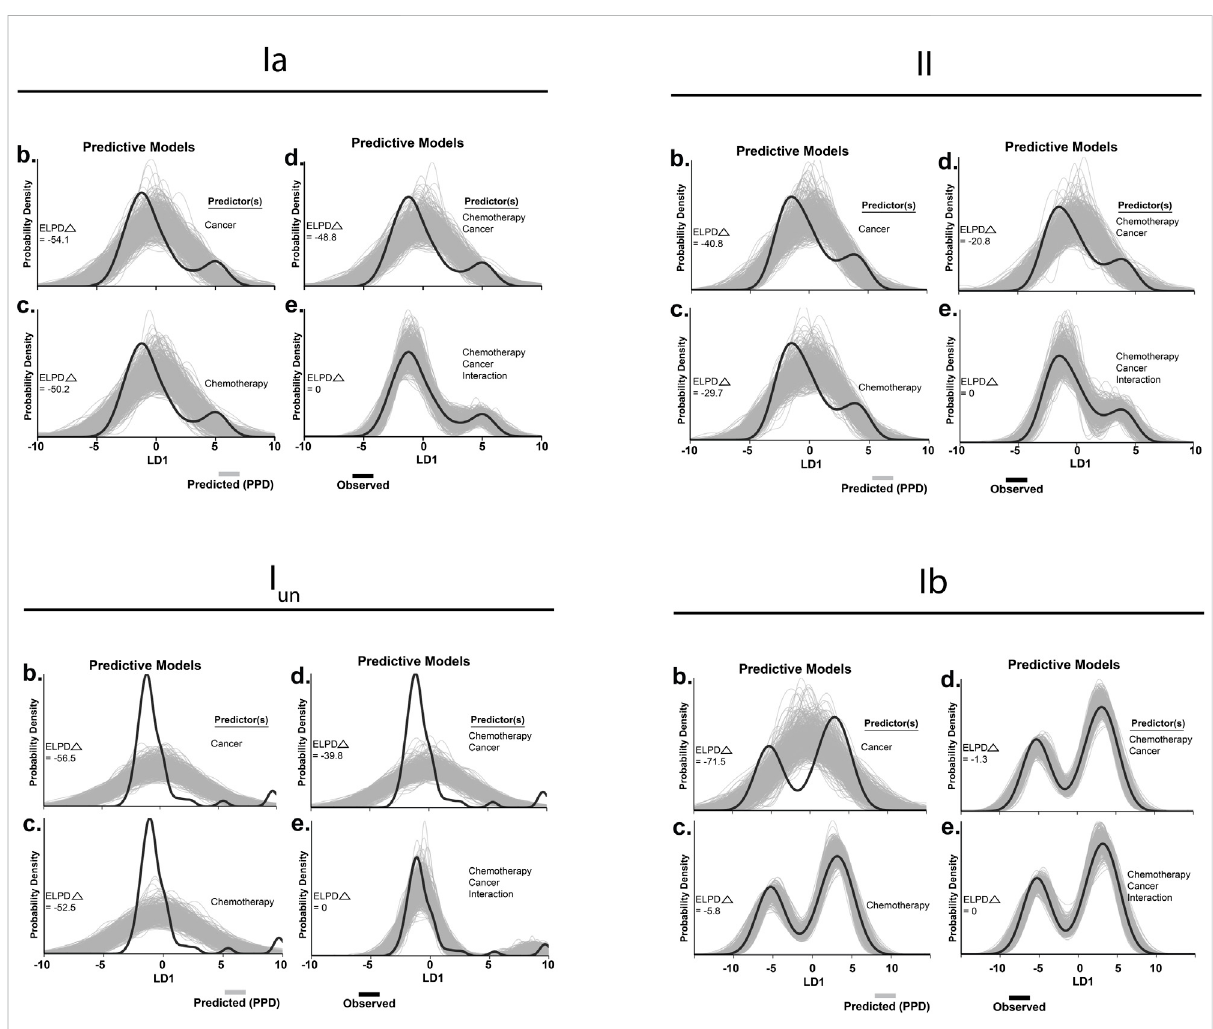
FIGURE 4 Hierarchical Bayesian modeling. Tests for signi fi cant group differences in LD1 scores recon fi gured to operate in a predictive fashion in spindle group Ia (A) , group II (B) , unclassi fi ed spindle (C) , group Ib (D) . Predictors included in each model are listed to the right of each subplot (1 – 4). Generative models in utilizing one (1 and 2) or both independent 3) predictor(s) for posterior prediction. The generative model in 4) utilizes both independent predictors and aninteraction termfor posterior prediction. Grey linesinrepresent500novel (generative) samples drawn fromthe posteriordistributions.BlacklinesillustrateexperimentallyobservedmeanLD1score.Predictiveaccuracywasmeasuredbycalculatingexpectedlog predictive density (ELPD) for each model and benchmarked off of the highest performing model. Delta ELPD ( Δ ) indicates difference from optimal model. Negative models represent worse predictive